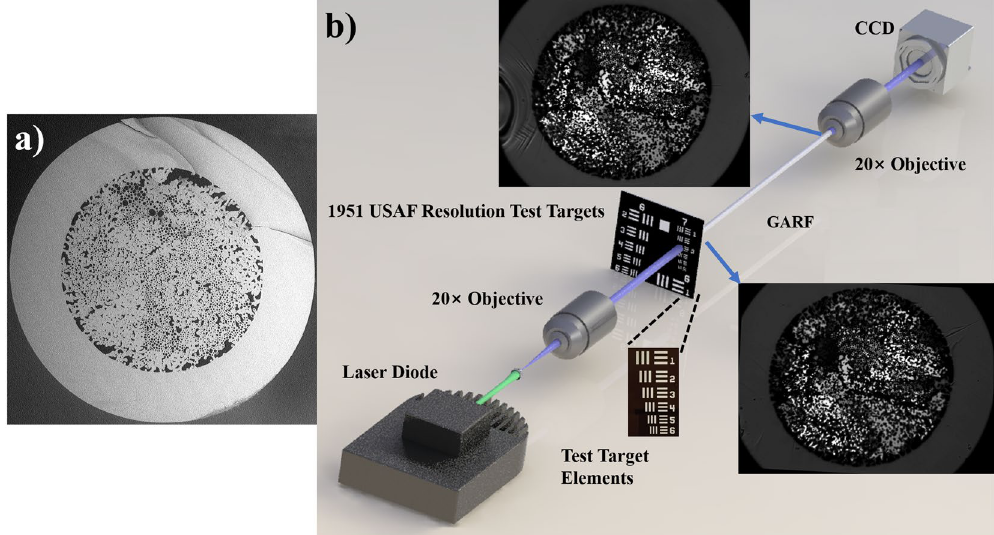
Figure 1. ( a ) SEM cross-section image of GARF(1). ( b ) Schematic of the image transport experimental